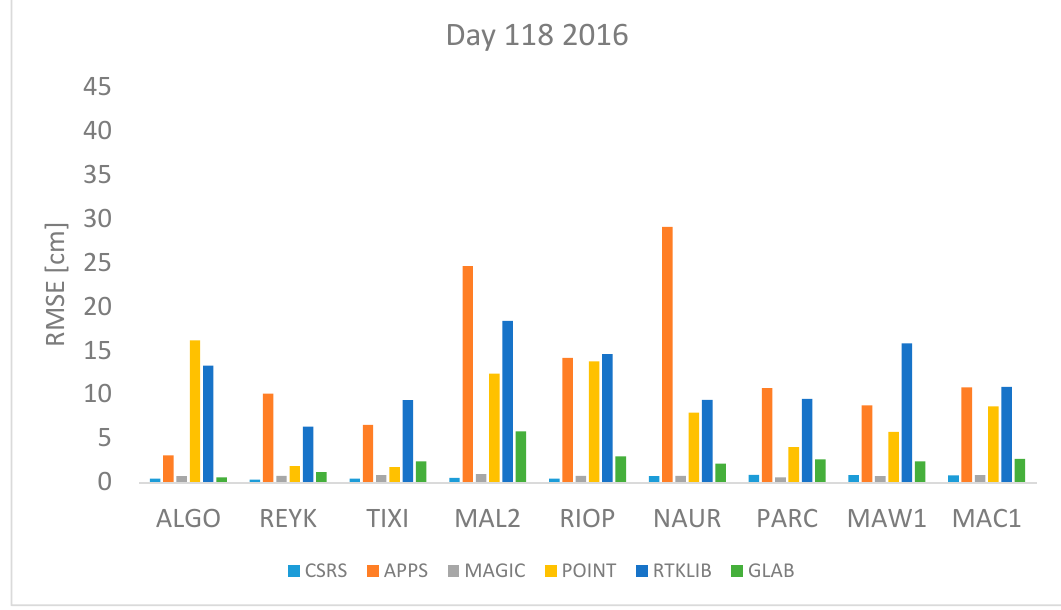
Figure 3. RMSE in centimeters for day 118 2016.